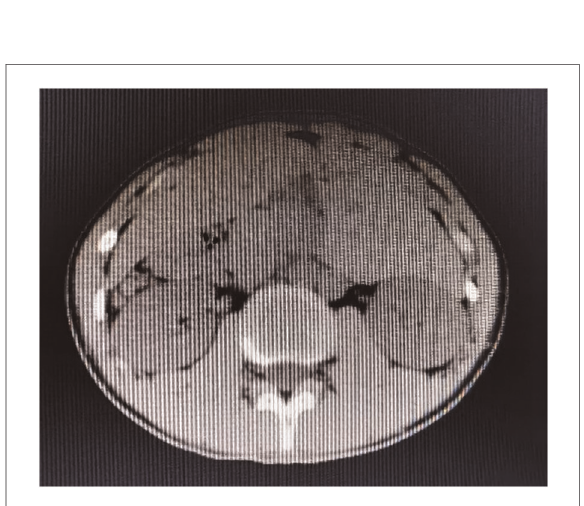
FIGURE 2 Abdominal CT reexamination on 24 November 2018. The spleen was absent.